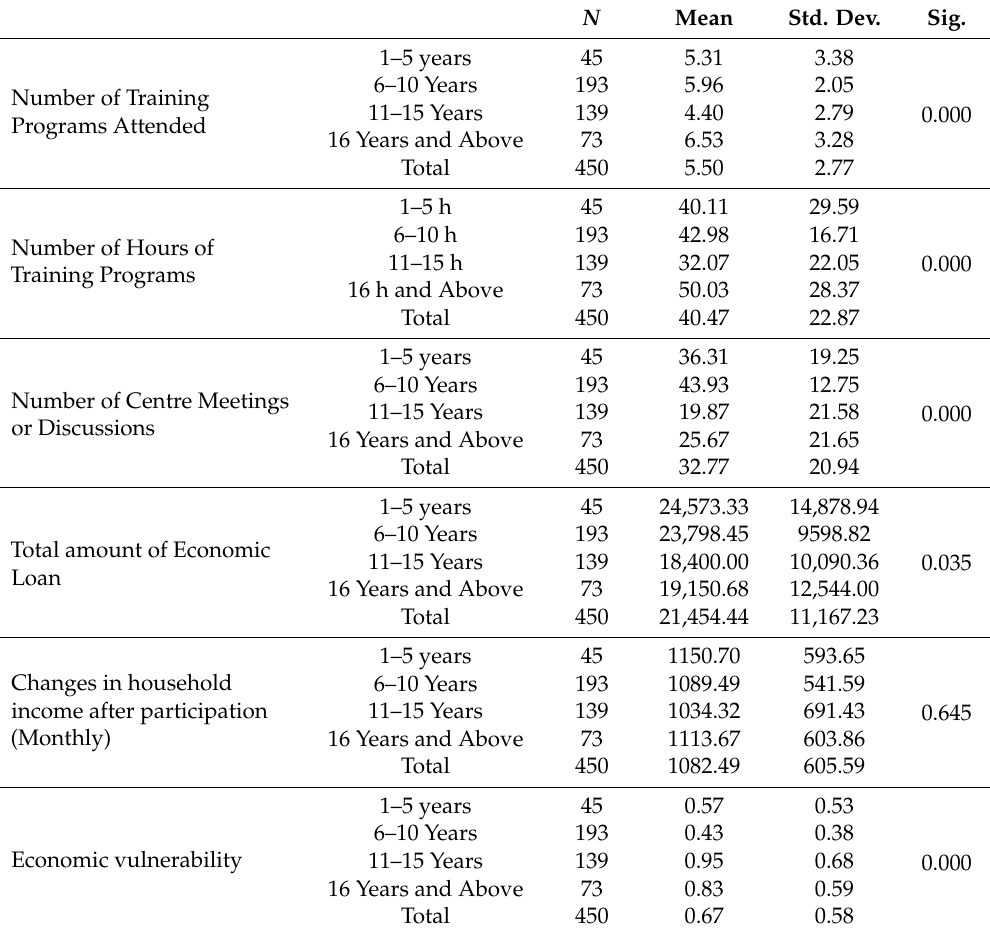
Table 3. Length of Participation and Key Determinants. N Mean Std. Dev.